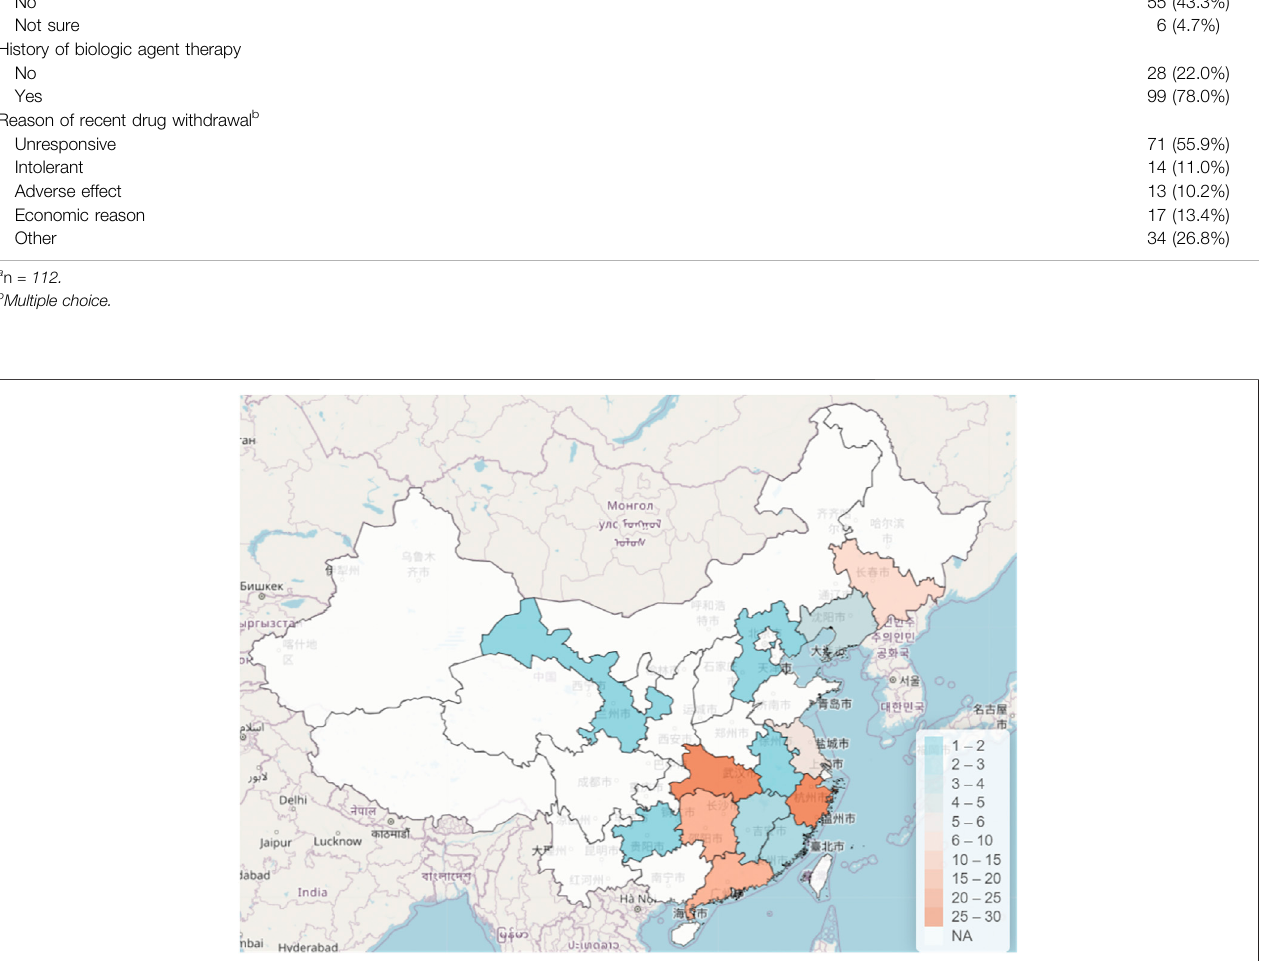
FIGURE 1 | Distribution of